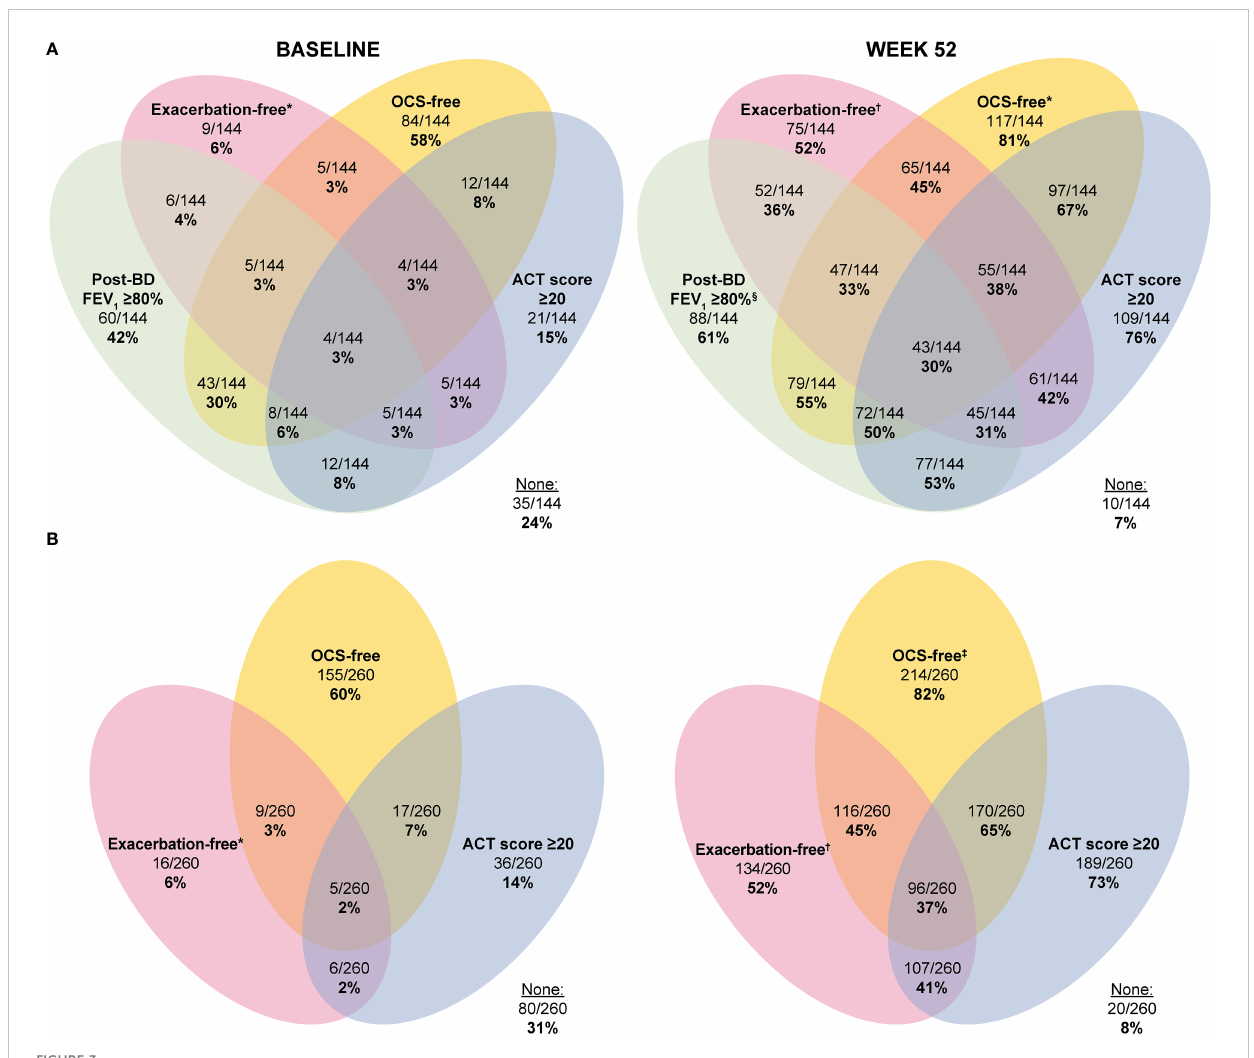
FIGURE 3 Proportion of patients with severe eosinophilic asthma meeting one or multiple elements of the four- (A) and three-component (B) clinical remission de fi nitions at baseline and after 1 year of treatment with mepolizumab. In panel A, 174 patients were excluded owing to missing post- bronchodilator FEV 1 values or ACT scores at Week 52. In Panel B, 58 patients were excluded due to missing ACT scores at Week 52. *No exacerbations experienced in the 12 months prior to baseline (Week 0). † No exacerbations experienced up to study Day 365. ‡ Patients were not receiving OCS at baseline (Week 0) and remained off OCS at Week 52; § Post-bronchodilator FEV 1 percent predicted ≥ 80% at Week 52. ACT, Asthma Control Test; BD, bronchodilator; FEV 1 , forced expiratory volume in 1 second; OCS, oral